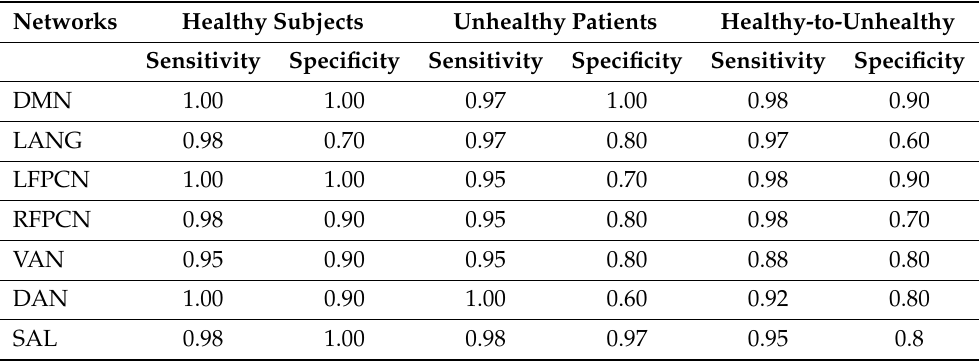
Table 5. Model Evaluation for individual networks of healthy subjects, unhealthy patients and the transfer learning (Healthy to